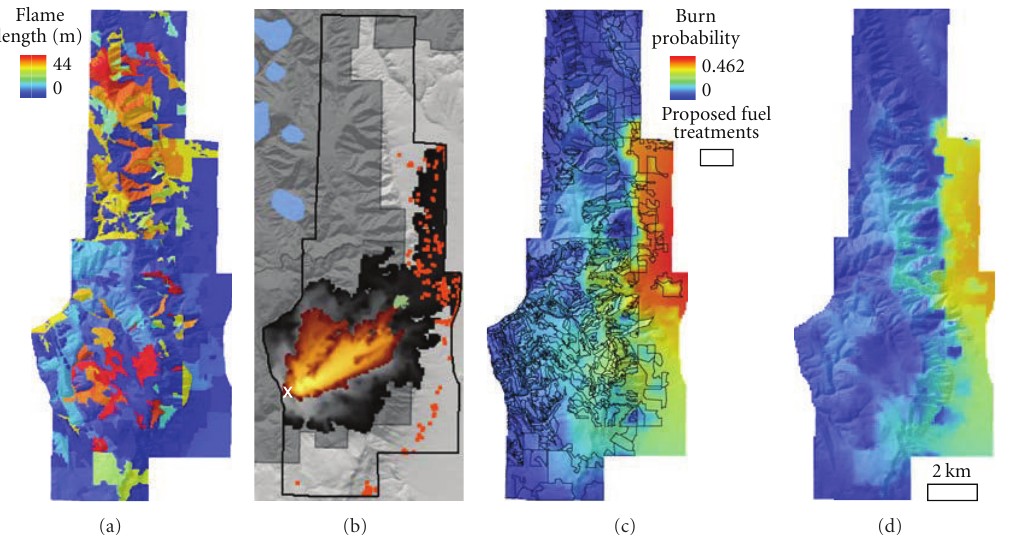
Figure 2: Images from FlamMap showing selected wildfire behavior outputs for the Mt. Emily study area. Panel (a) shows flame length from a static FlamMap run, (b) is single fire simulation from a point ignition, (c) is burn probability simulation of 10,000 wildfire ignitions and outlines of proposed treatment areas, (d) burn probability map as in (c) with fuel treatments simulated. All images were adapted from